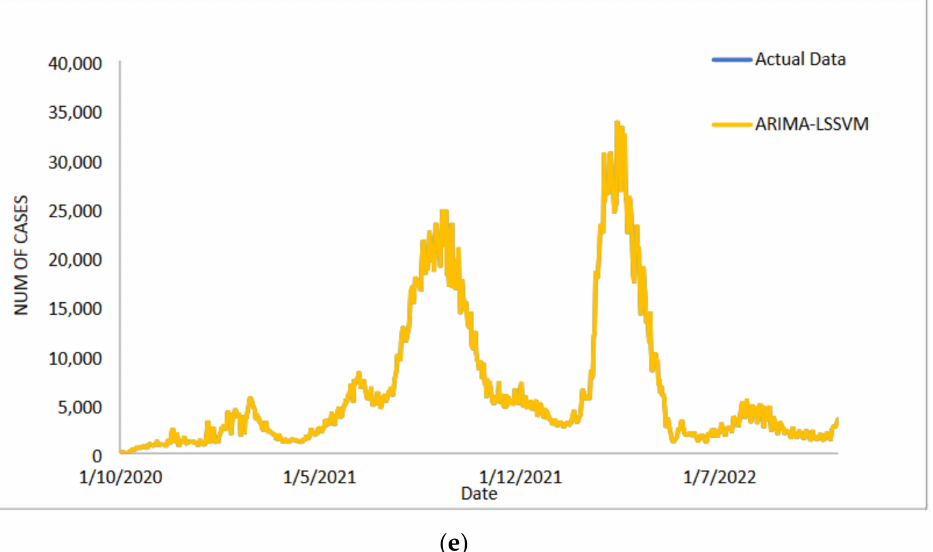
Figure 11. Results obtained from the proposed model for daily new recovered COVID-19 cases dataset: ( a ) actual data vs. ARIMA model, ( b ) actual data vs. LSSVM models, ( c ) actual data vs. SVM model, ( d ) actual data vs. ARIMA–SVM models, ( e ) actual data vs. ARIMA–LSSVM